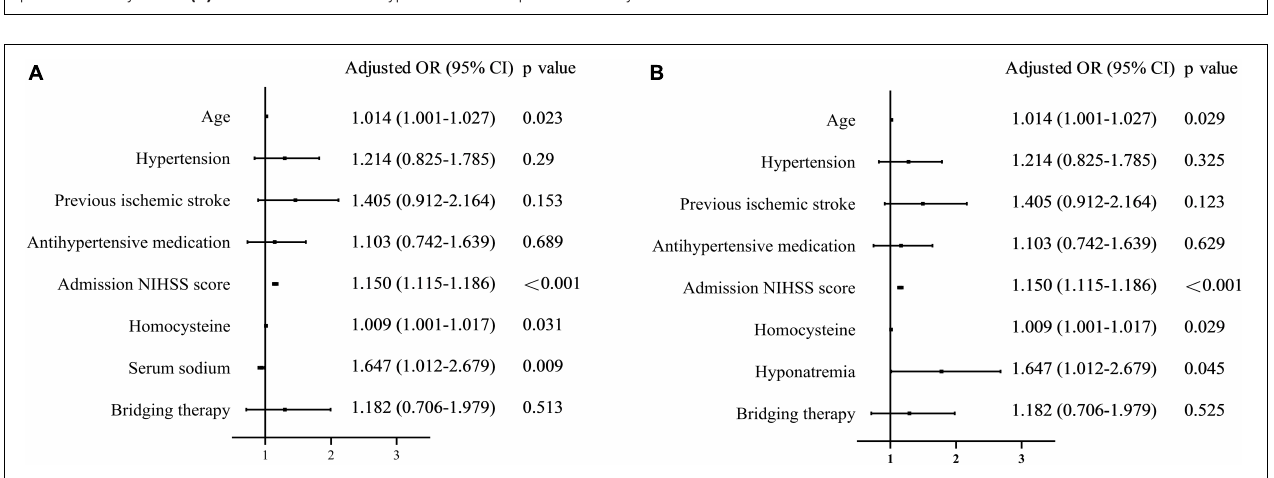
FIGURE 4 | An association between serum sodium levels/hyponatremia and 3-month outcomes. (A) Association between serum sodium levels and 3-month outcomes. (B) Association between hyponatremia and 3-month